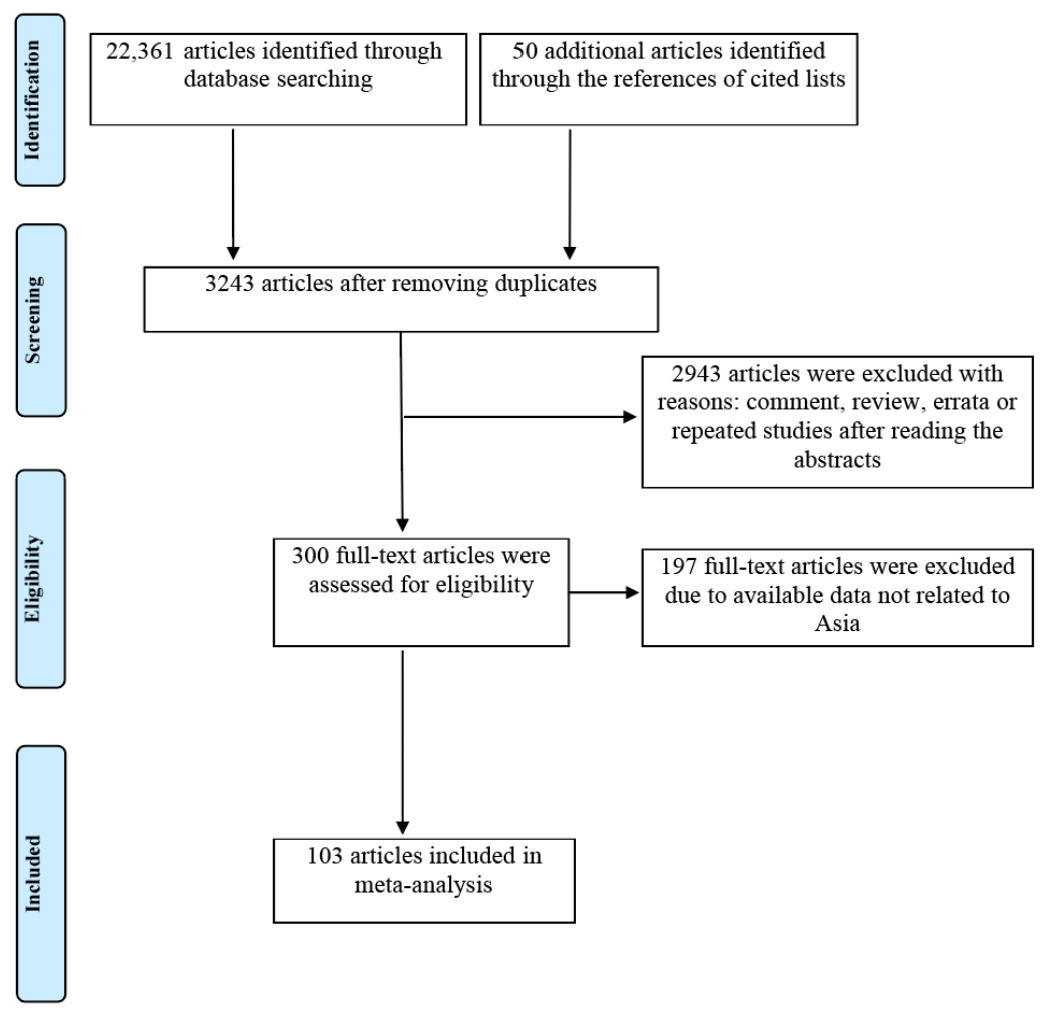
Figure 1. Flow chart of study search and selection process.